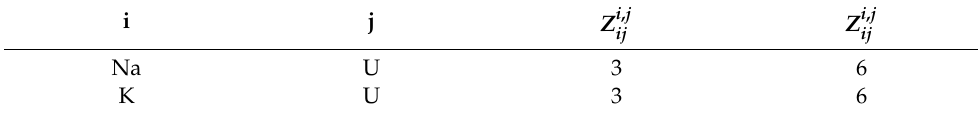
Table 2. Cation-cation coordination numbers Z i , j dynamic